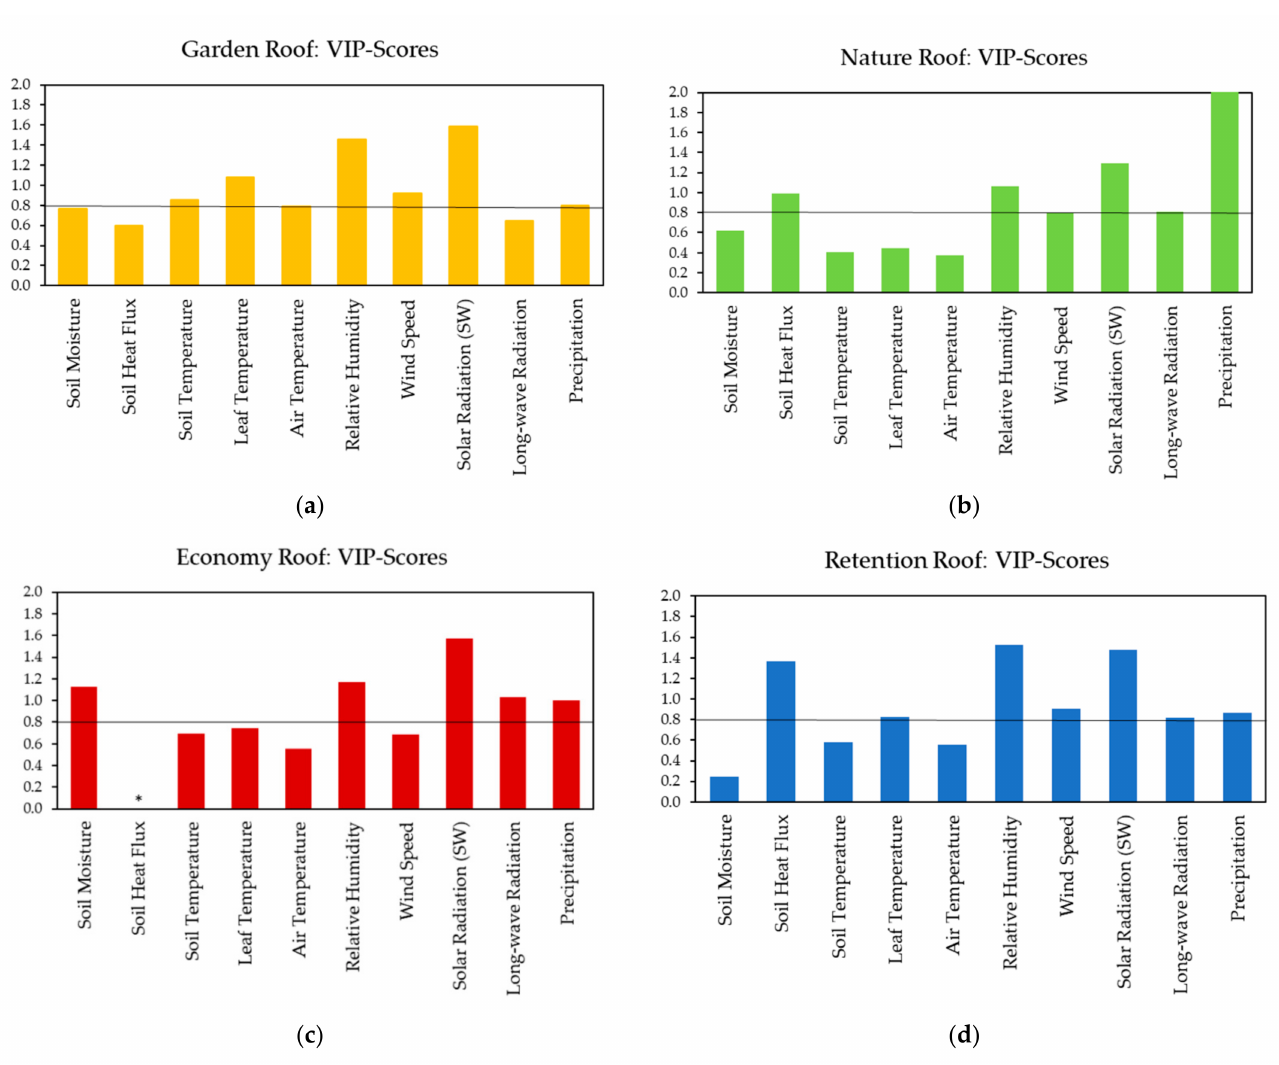
Figure 9. VIP-Scores resulting from the PLS-regression of the different green roof systems. ( a ) 7 components, evapotran- spiration explained: 85.38%, CVadjusted: 0.2538; ( b ) 4 components, evapotranspiration explained: 62.40%, CVadjusted: 0.2992; ( c ) 5 components, evapotranspiration explained: 75.42%, CVadjusted: 0.1807 ( d ) 5 components, evapotranspiration explained: 74.50%, CVadjusted: 0.2128. * Due to sensor failure, the soil heat flux variable did not produce enough values to be included in the regression for the Economy Roof